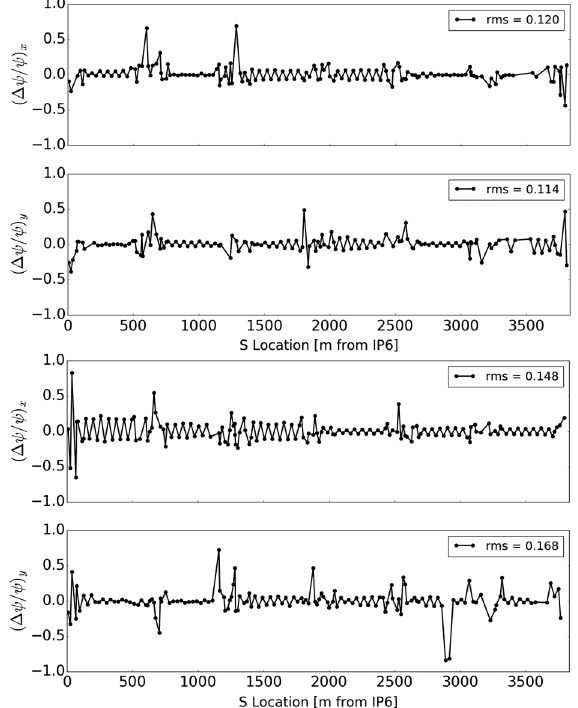
FIG. 10. Measured phase error ð Δ ψ = ψ Þ zontal and vertical planes (top) and the Yellow horizontal and vertical planes